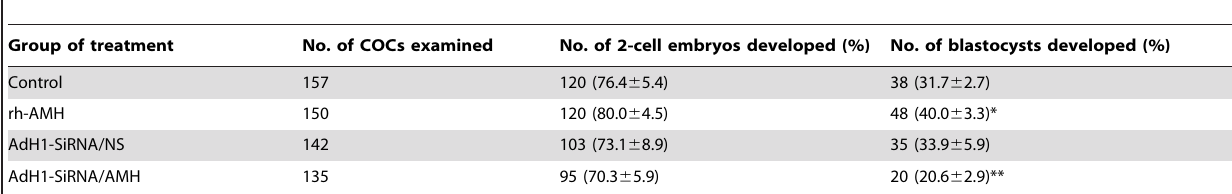
Table 3. Subsequent embryonic development of immature COCs matured in IVM-medium without rh-AMH (Control) or